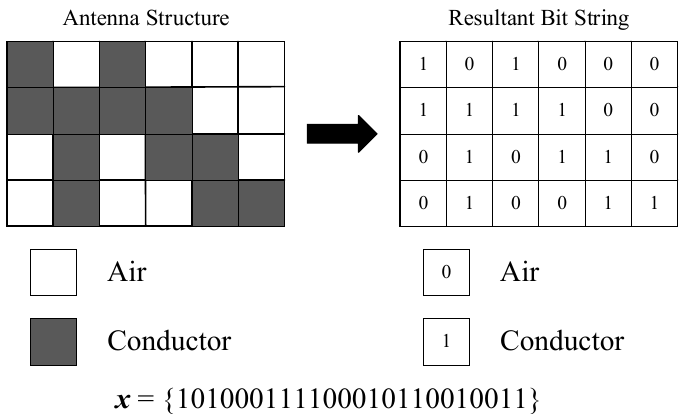
Figure 6. The relationship between the topology structure of the antenna and its corresponding binary code.